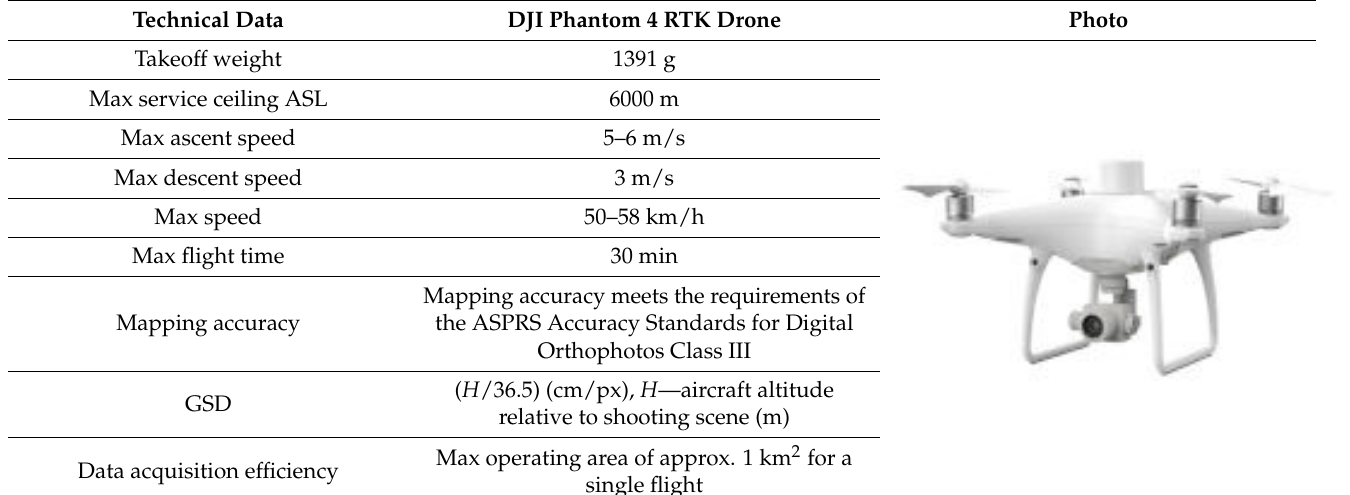
Table 1. The technical data of DJI Phantom 4 RTK drone.